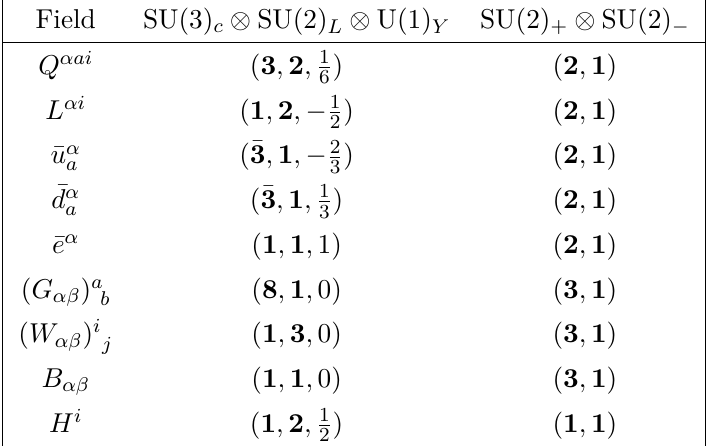
Table 1. The SM fields and their transformation properties under the SM gauge group G SM and the Lorentz group. The final unbolded number in the 3-tuples of the G SM column represents the U(1) Y charge of the field, normalised such that Q = I 3 + Y . For the fermions a generational index has been suppressed.